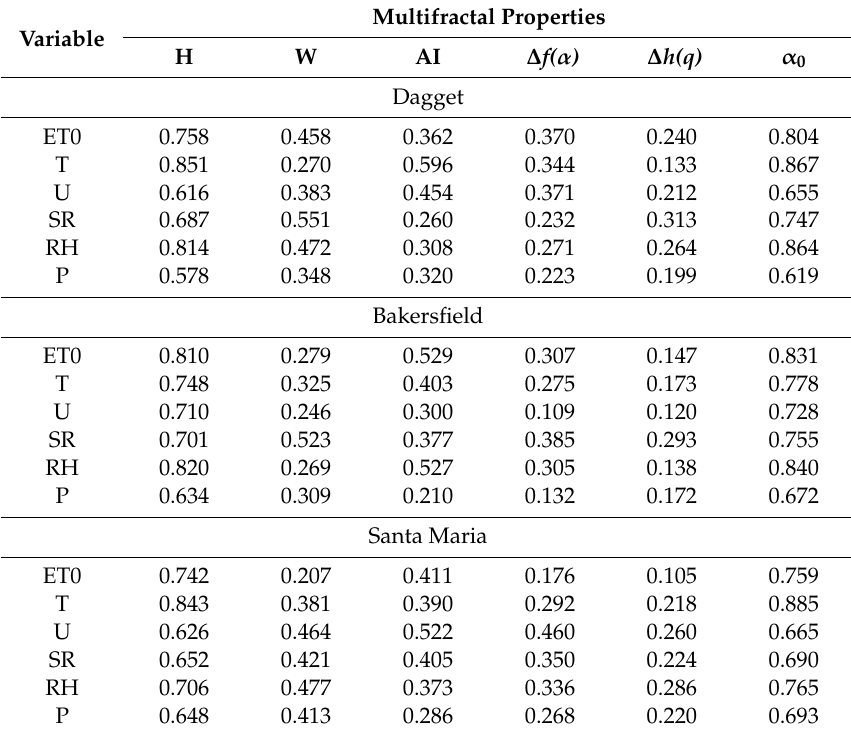
Figure 3. Fluctuation function plots of different agro-meteorological time series of different stations for q = 2. ( a ) reference evapotranspiration; ( b ) temperature; ( c ) wind speed; ( d ) solar radiation; ( e ) relative air humidity; and ( f ) air pressure. Table 2. Multifractal parameters of agro-meteorological datasets of